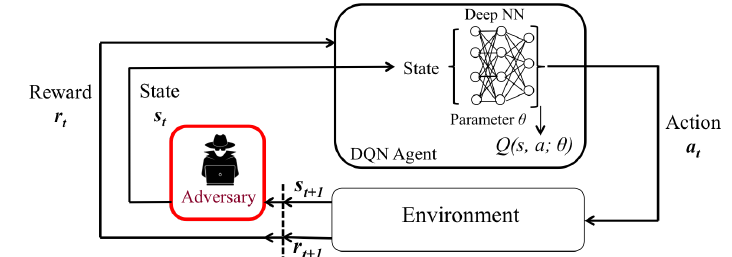
Figure 2. A DQN agent’s structure affected by an adversarial